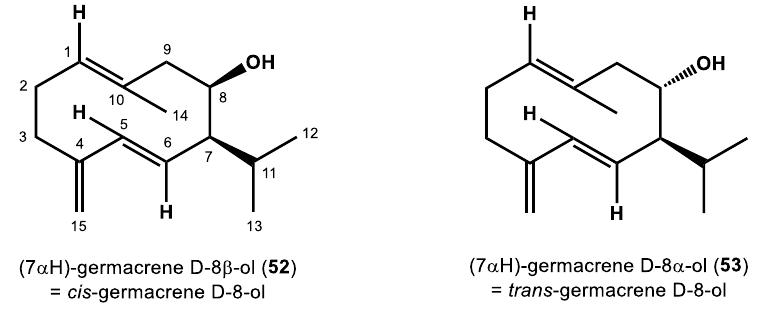
Figure 2. Structure of compounds 52 and 53 .